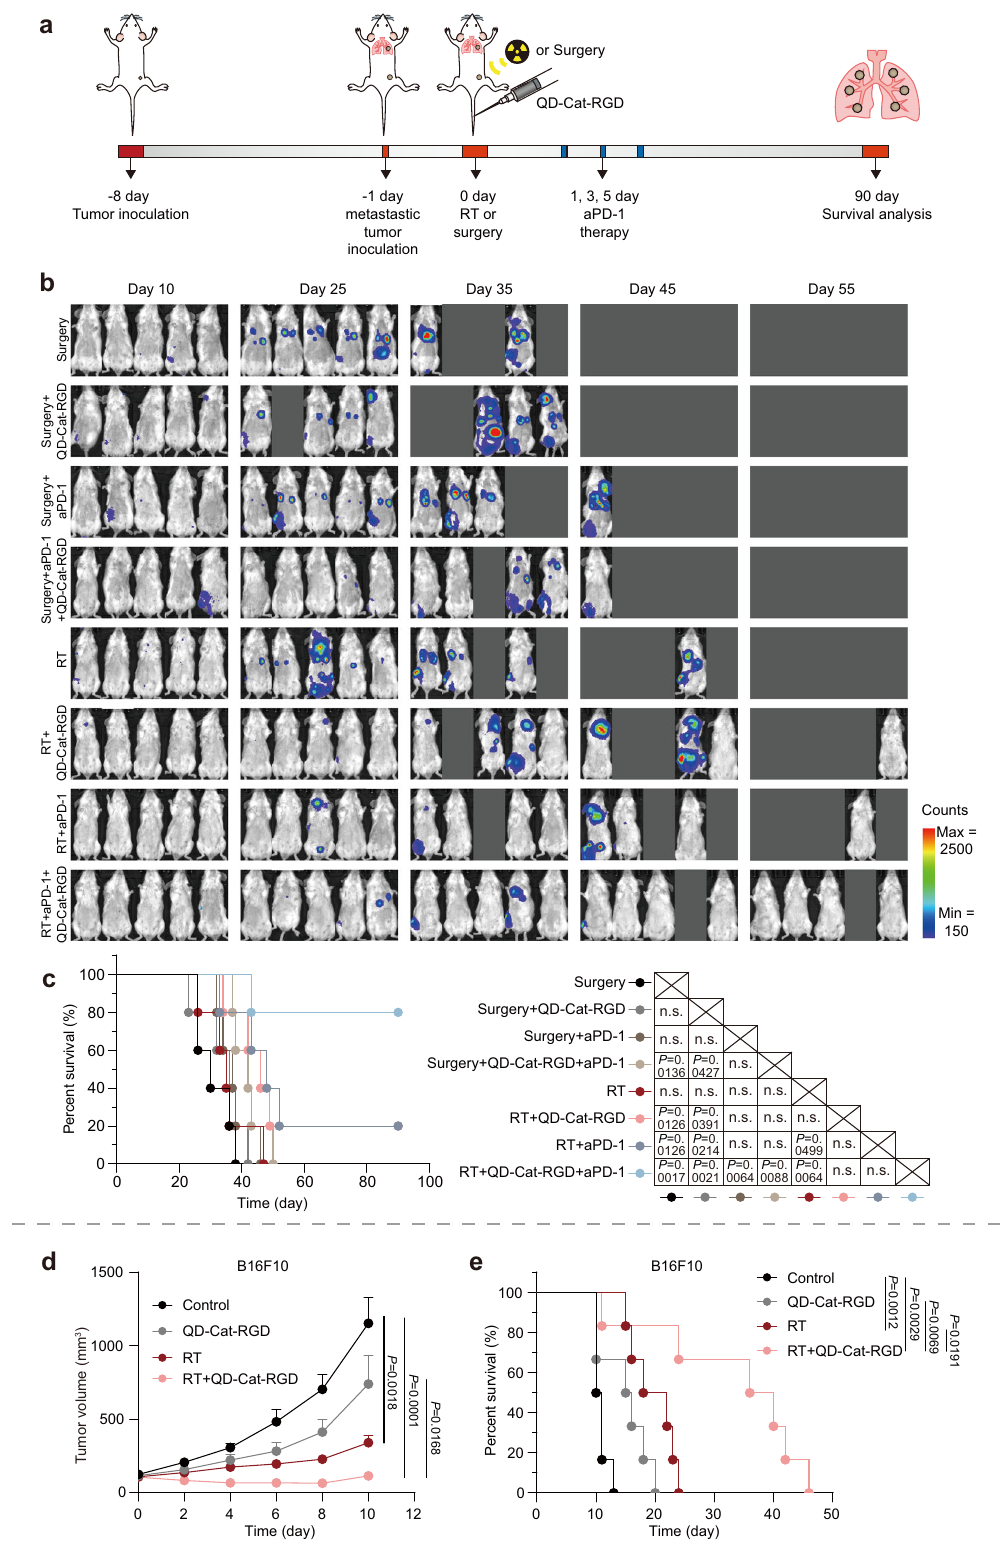
Cytokine and ATP detection . For the secretion levels of HMGB1 and ATP from cells in vitro, cells were fi rst inoculated with QD-Cat-RGD (50 μ gmL − 1 ) or QD- RGD (50 μ gmL − 1 ) for 8h and then treated with RT (6 Gy). Culture medium samples were isolated from the cells with different treatments under hypoxic conditions (37 °C, 1% O 2 , 5% CO 2 ) after 24h. HMGB1 was detected by a mouse HMGB1 ELISA kit (IBL-International, Cat ST51011). ATP was detected by an ATP